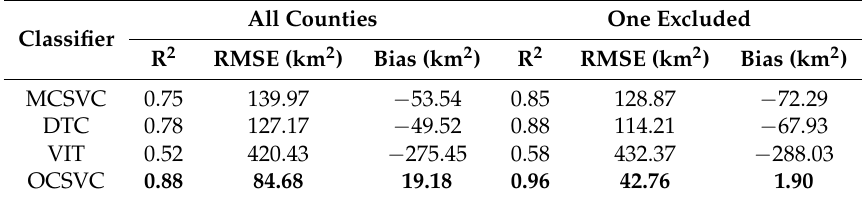
Table 6. Assessment of accuracy for rice acreage estimation with the four classification methods.